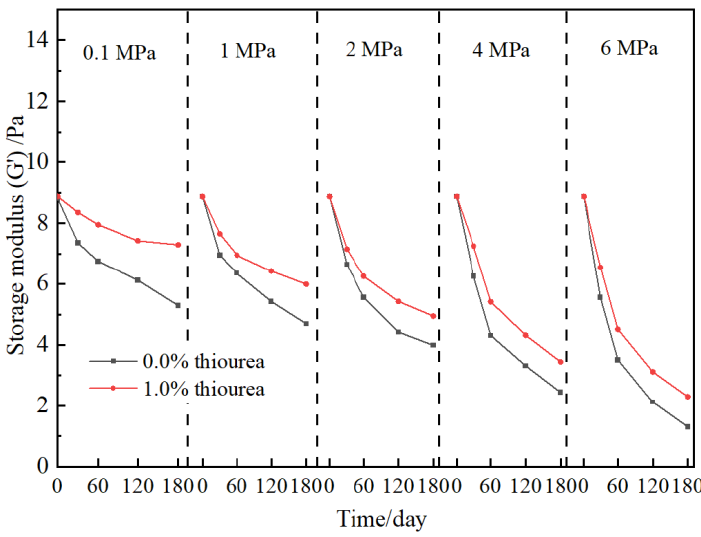
Figure 2. Effect of thiourea on polymer gel stability at elevated flue gas